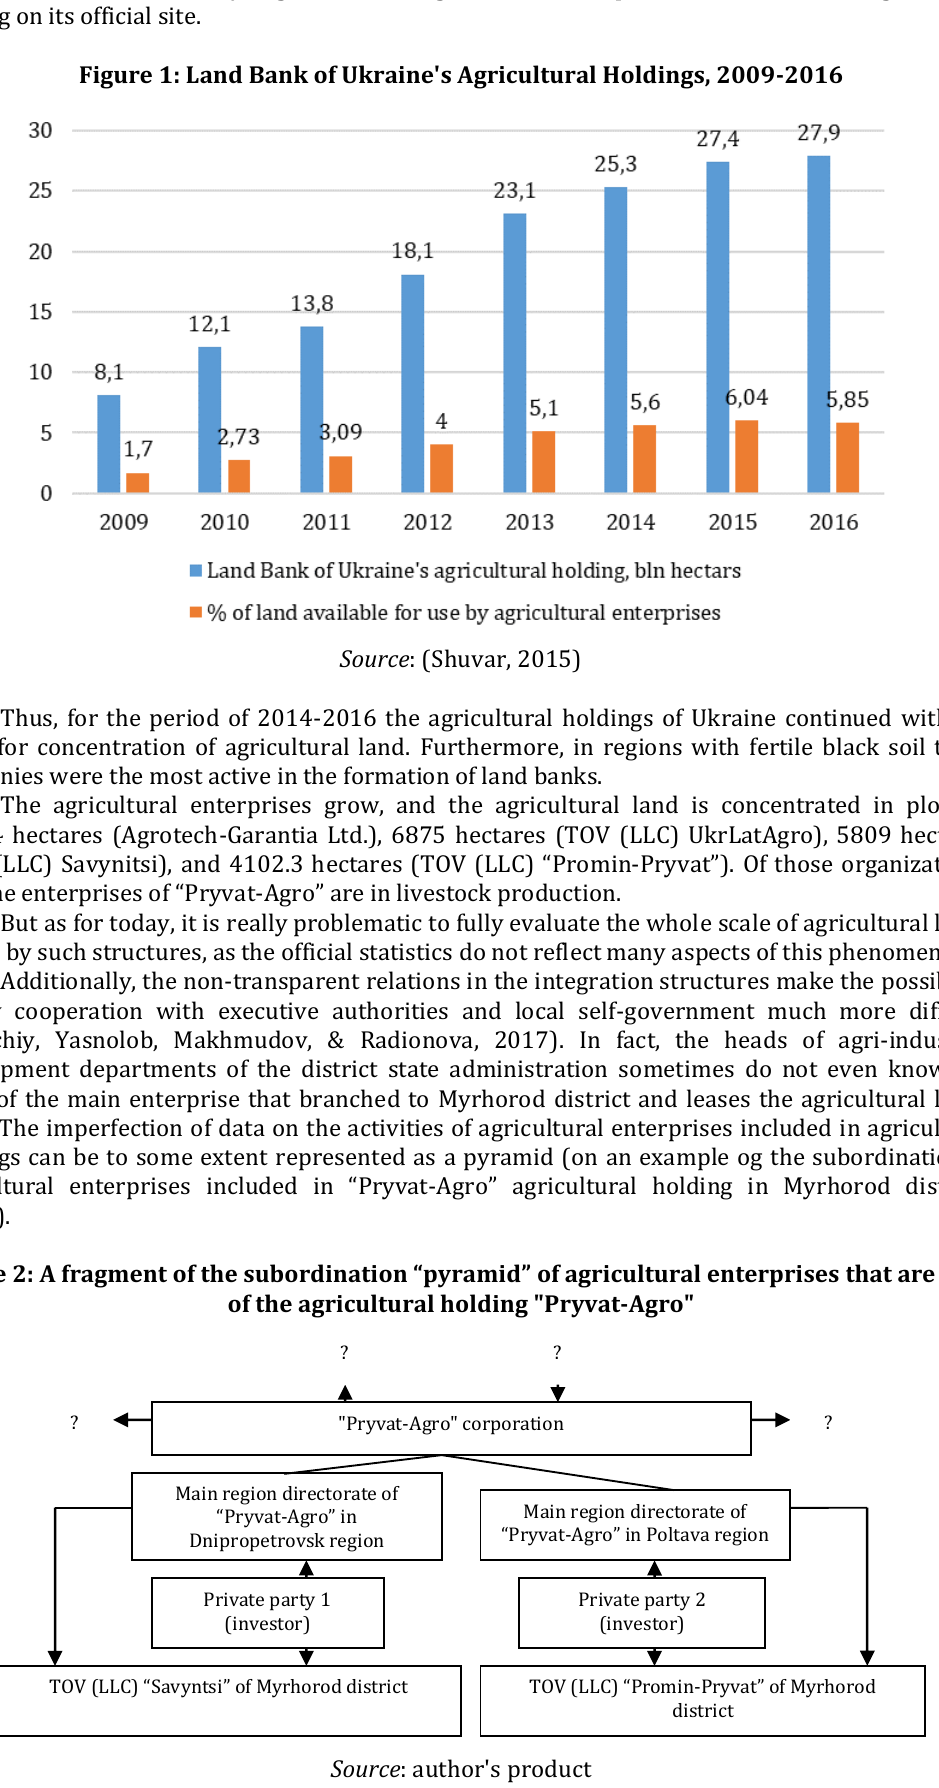
Figure 1: Land Bank of Ukraine's Agricultural Holdings, 2009-2016